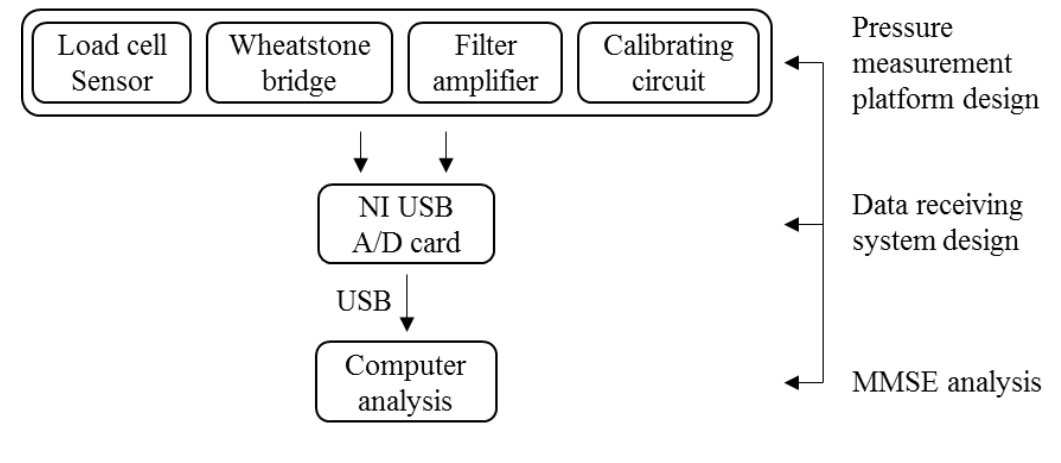
Figure 1. The center of pressure and complexity monitor system (CPCMS) design flow